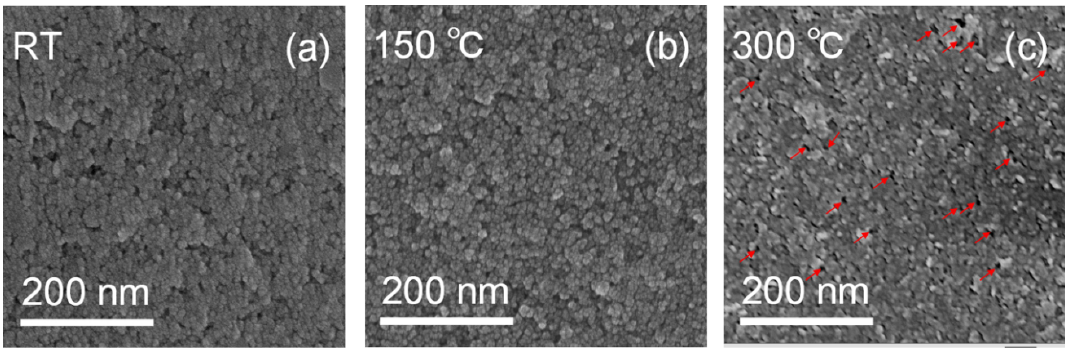
Figure 5. SEM images of NiO x films after ( a ) RT; ( b ) 150 °C and ( c ) 300 °C annealing. The NiO x films are spin-coated three times and the volume ratio in NiO x inks is IPA:DI water = 1:3. The red arrows indicate the voids.